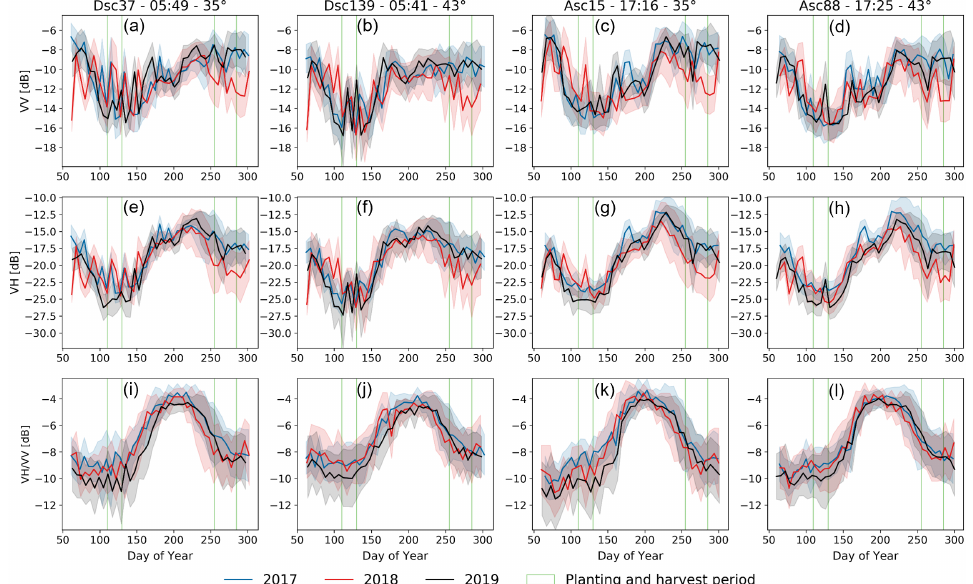
Figure 5. Sentinel-1 descending (RO: 37 and 139) and ascending (RO: 15 and 88) backscatter of VV ( a – d ), VH ( e – h ) and VH/VV ( i – l ) for onion parcels in Vechtstromen-Noord for the years 2017, 2018 and 2019. The title of the columns states whether the data are from a descending (Dsc) or ascending (Asc) overpass, the RO number, the overpass time in UTC and centre incidence angle to the study area. The shaded areas indicate the standard deviation calculated across all parcels. Vertical green lines indicate crop sowing and harvesting